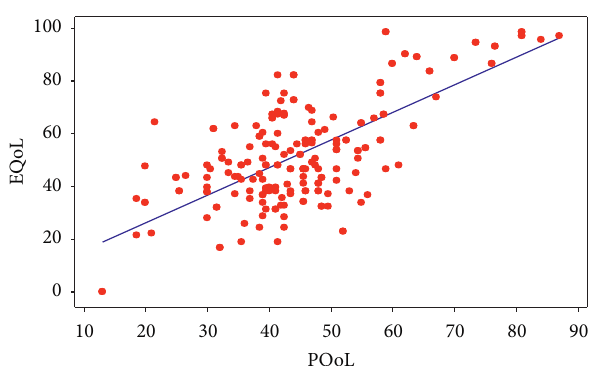
Figure 2: Scatter diagram of the relationship between physical and emotional qualities of